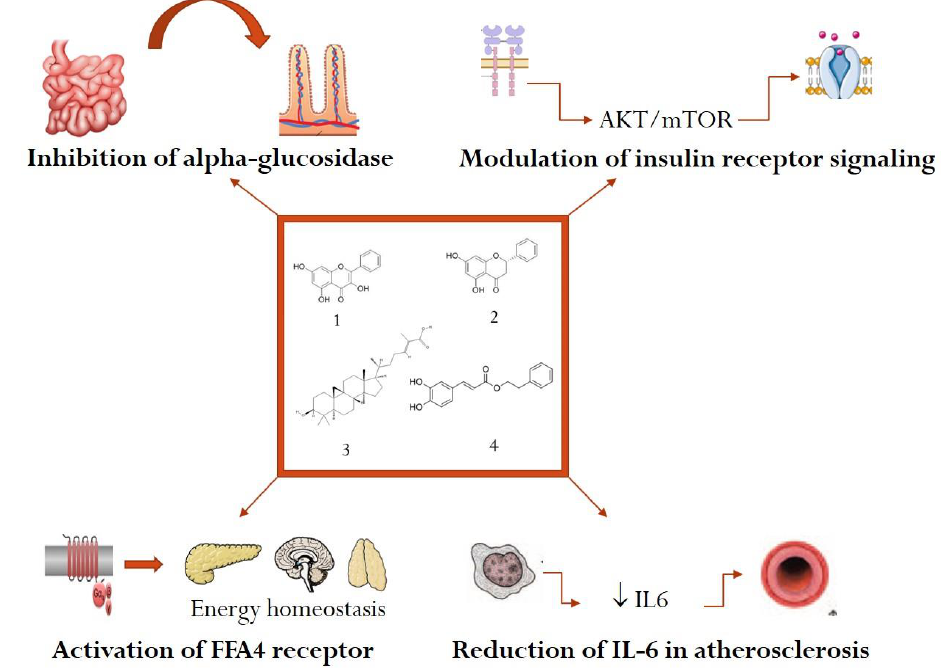
Figure 1. Examples of mechanisms of action of selected active constituents from propolis in metabolic diseases (1—galangin, 2—pinocembrin, 3—mangiferonic acid, 4—CAPE).